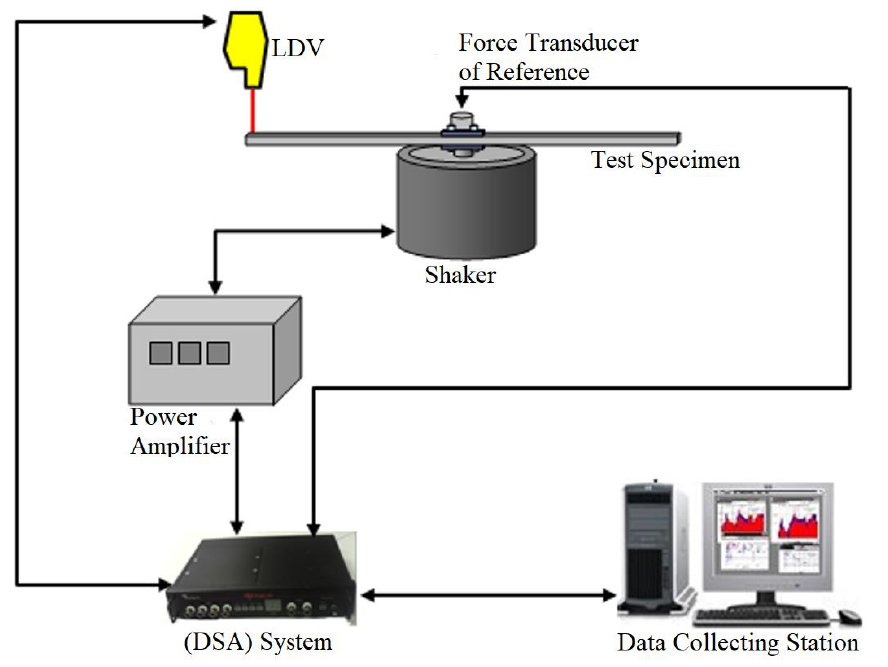
Figure 14. Schematic outline of the experimental vibration setup.